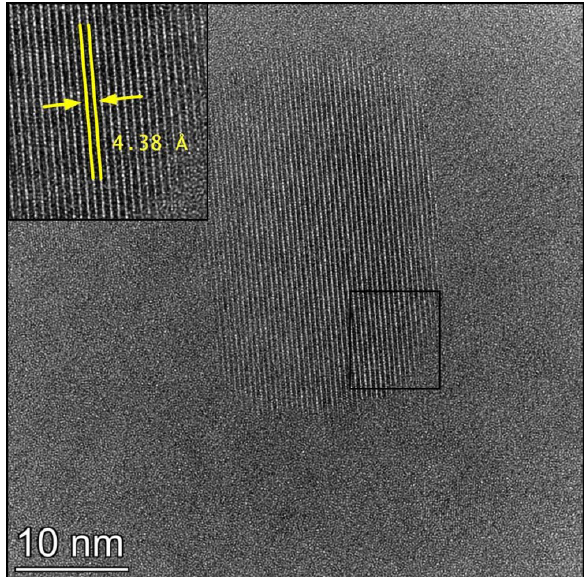
Figure 8. HR-TEM micrograph of a Mg 2 Ni crystal embedded in the amorphous matrix of the MgNiCuY_CNT_5 composite. The inset shows a magnified view of the lattice